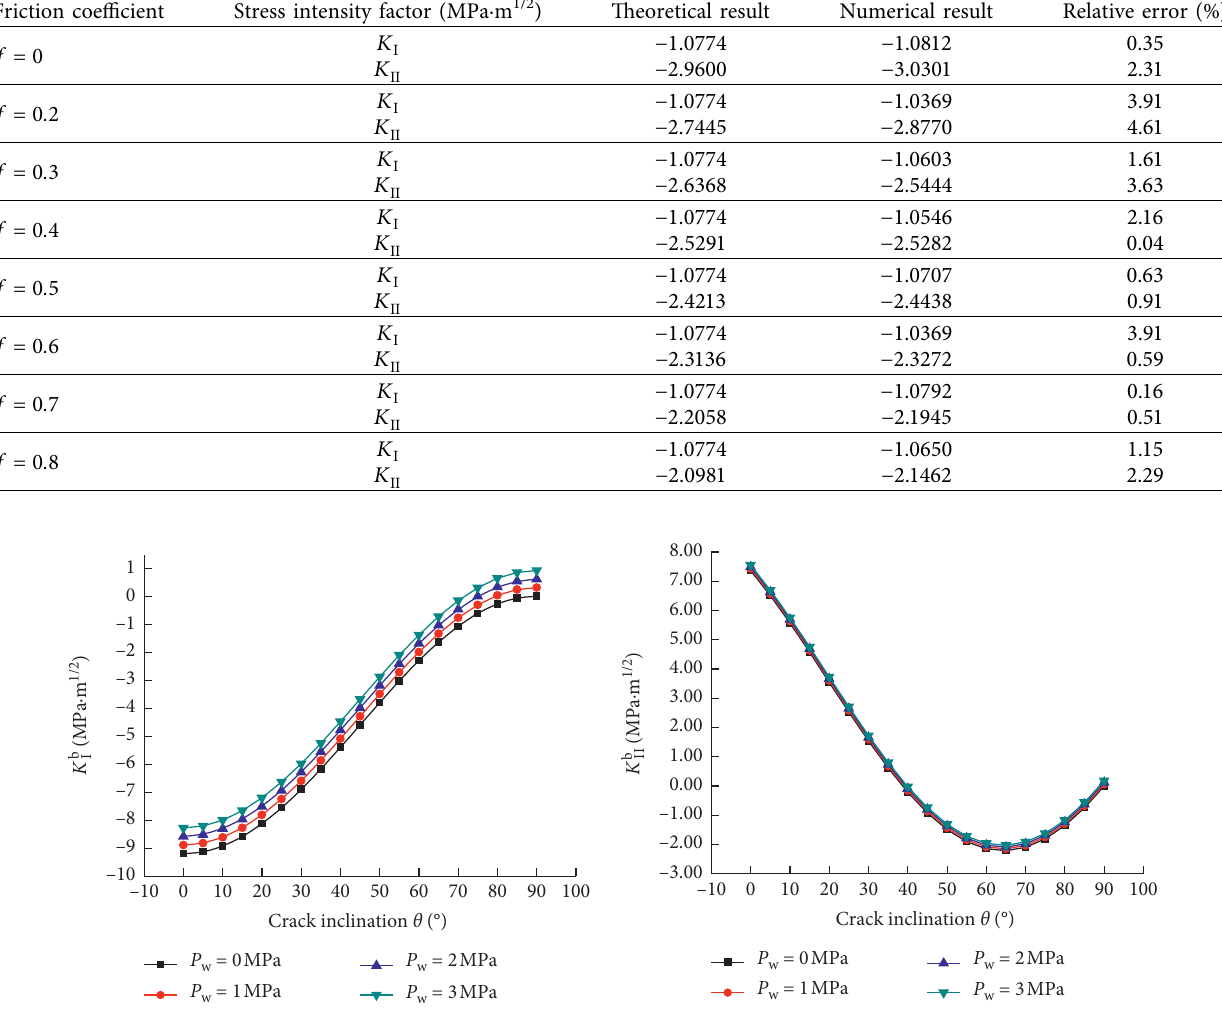
Table 2: Error analysis of theoretical and numerical results for closed crack.